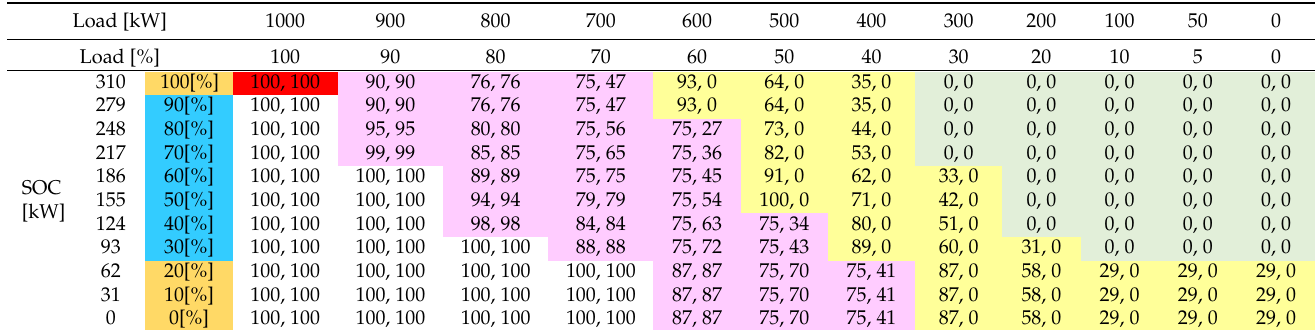
Table 2. Results obtained by proposed rule-based strategy of generator–battery hybrid system for designing neural network controller (Mode 1: Green, Mode 2: Yellow, Mode 3: Pink, Mode 4: